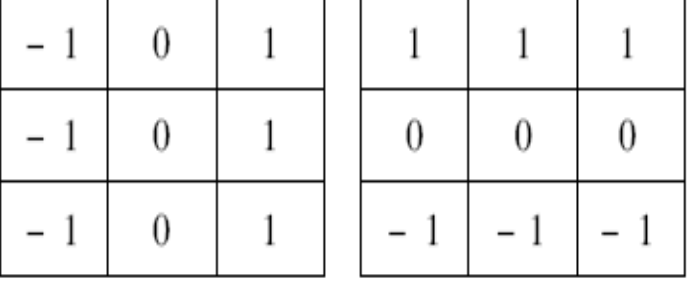
Figure 4. Prewi tt operator. Figure 4. Prewitt operator.